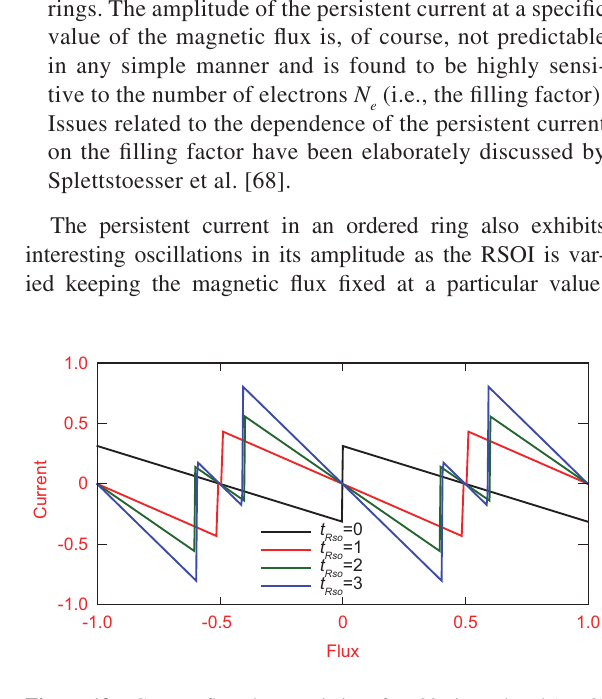
when t is set at Rso Dso